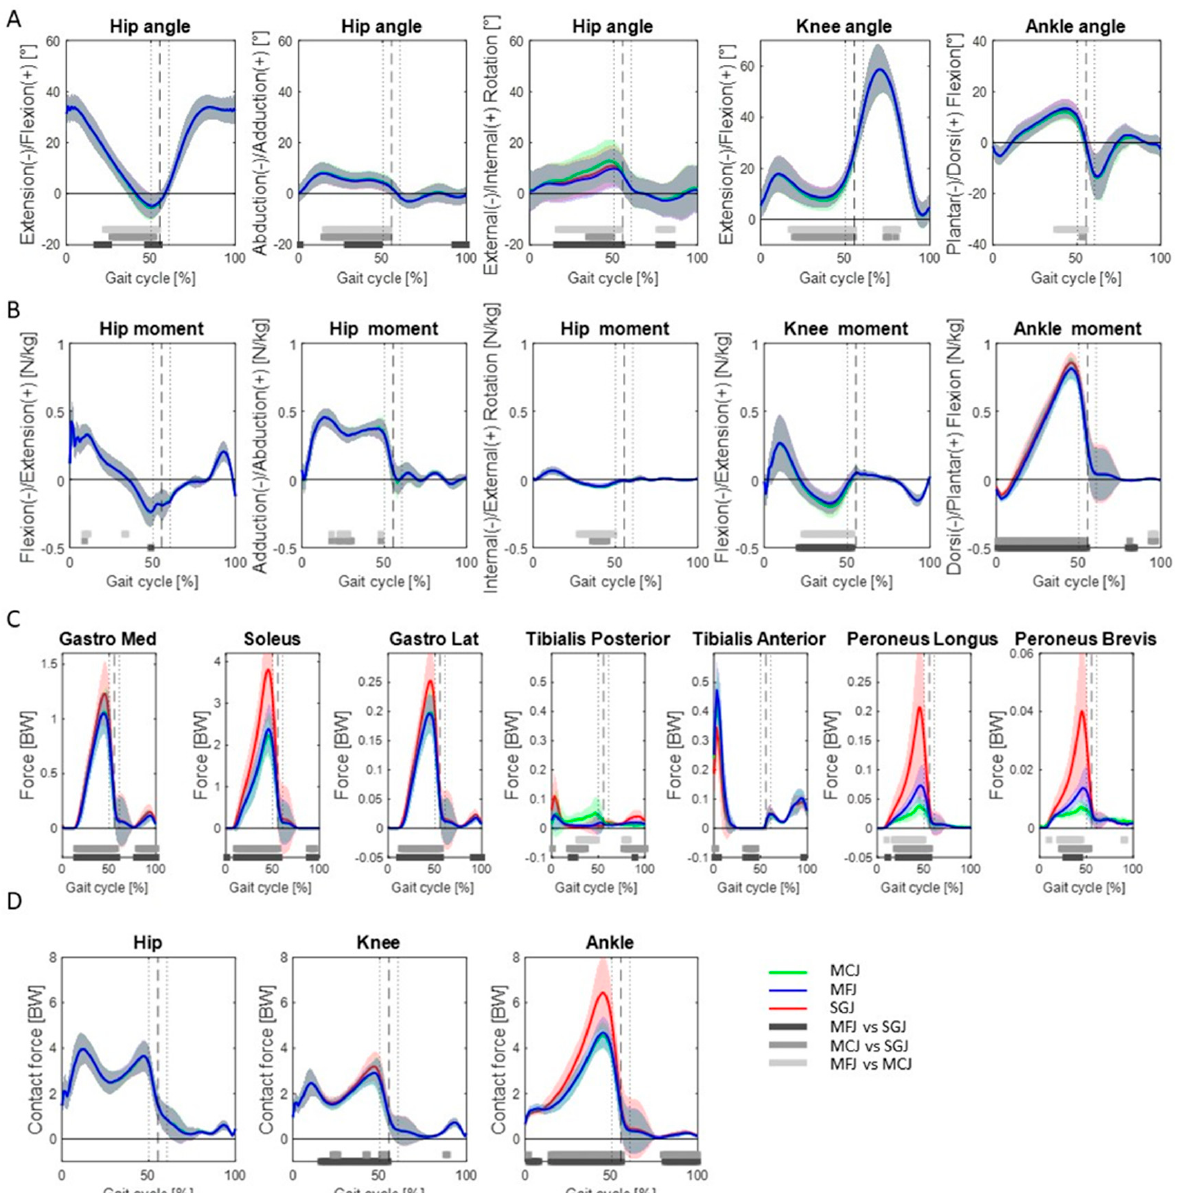
Figure 4. M1 outputs for the average cohort, considering the three ankle models: joint kinematics ( A ); joint moments ( B ); forces exerted for significant muscles at the ankle ( C ); joint contact force ( D ). Bottom gray bars represent the region of the gait cycle where post hoc tests were significant.